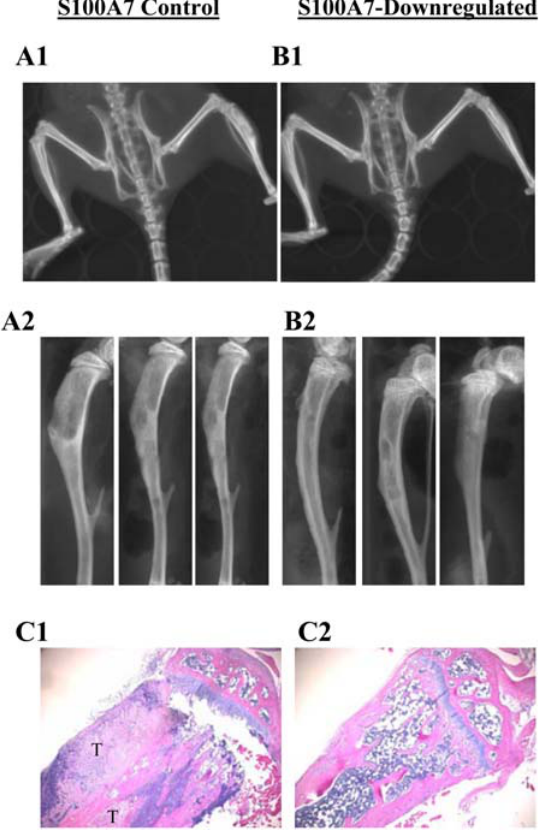
Figure 5. S100A7 downregulation decreases osteolytic lesions invivo. Cells were directly introduced into the tibias of 4 week-old mice, as described in Materials and Methods. Micro-CT scanning of live mice was done using a GE eXplore Micro-CT scanner (GE Healthcare Ltd, UK) at 93 m m resolution, 6 weeks after injection. The tibias were dissected out and scout view radiographs were taken with a micro-CT40 scanner at 12 m m resolution obtained from SCANCO Medical AG (Switzerland). There were osteolytic lesions, destruction of the cortex and extension of the tumor into the soft tissue in the mice injected with the control S100A7 cells (Panels A1 and A2). The cortex of the mice injected with the S100A7-downregulated cells was intact (Panels B1 and B2). Tibias were excised and processed for conventional histological examination. S100A7 control mice showed tumor-induced osteolysis (Panel C1), and the osteolysis was evident in all three injected mice as compared to mice injected with the S100A7-downregulated cells (Panel C2) (H & E staining, 20 6 ). The letter ‘T’ in panel C1 represents tumor. The experiments were repeated twice with identical results.